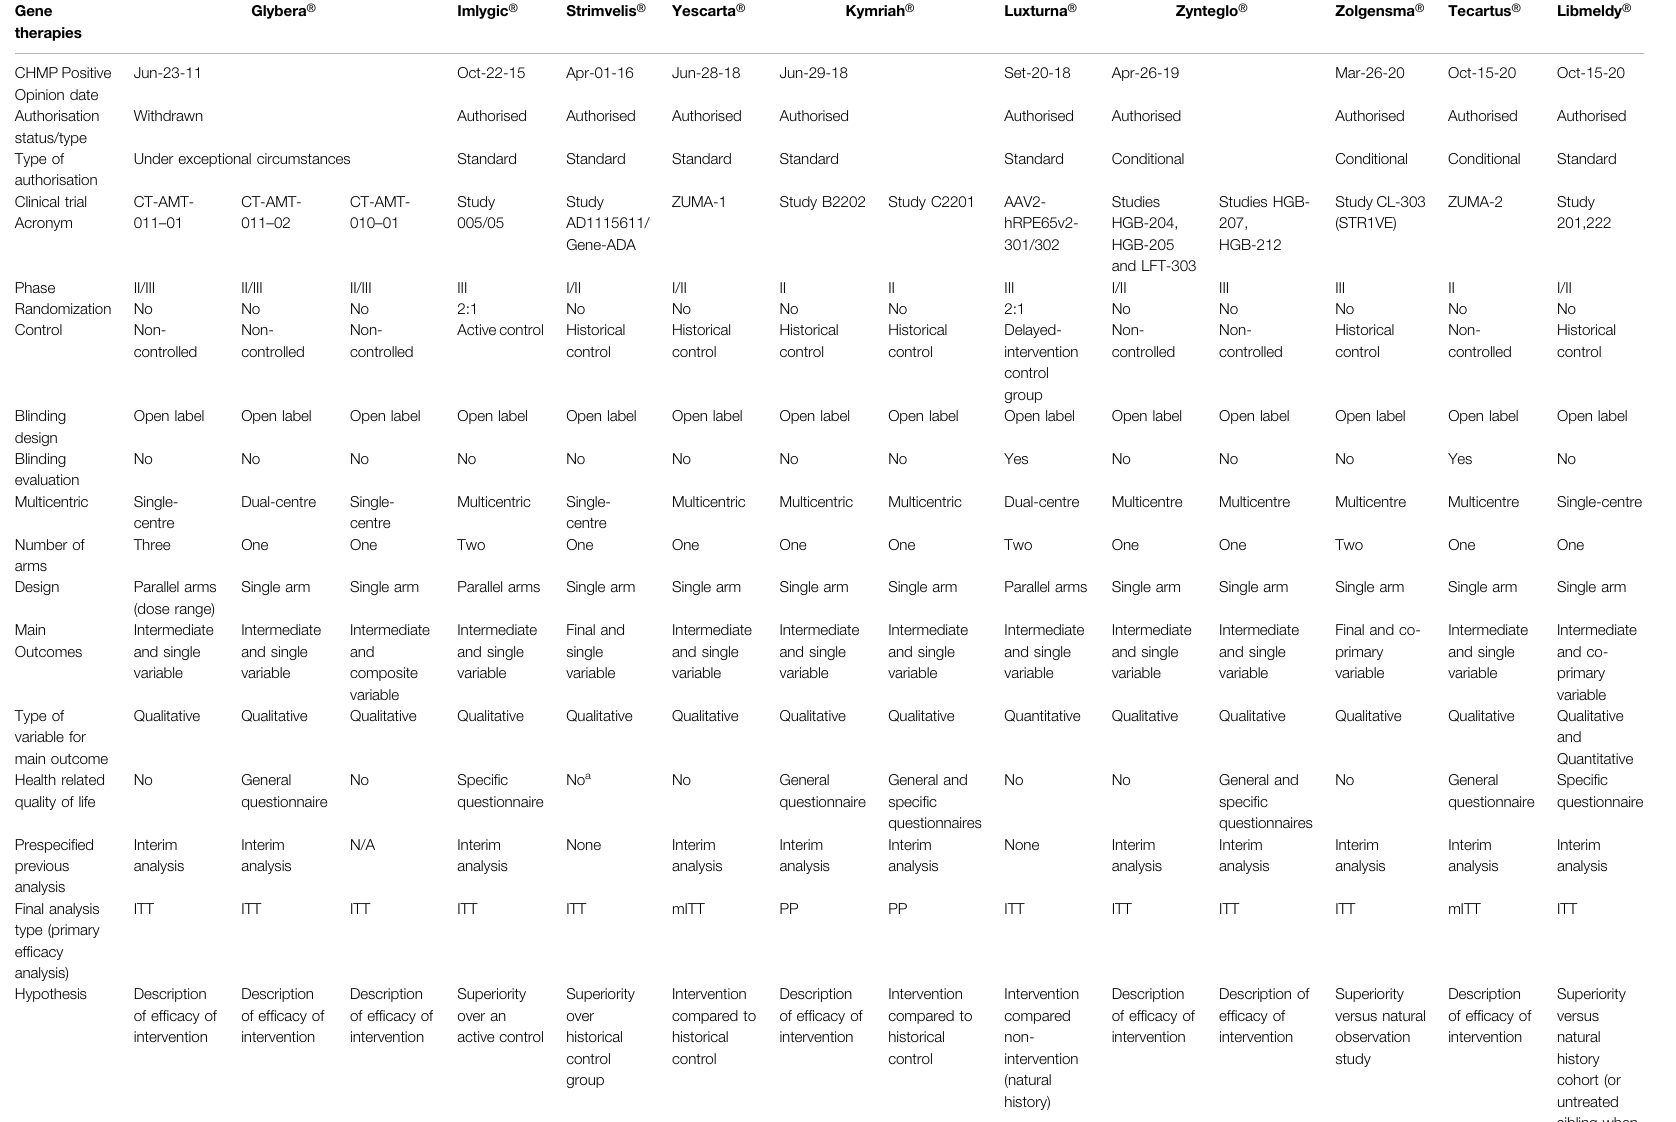
TABLE 3 | Design features of pivotal clinical trials for the approved gene therapy medicinal products in the European Union. Gene